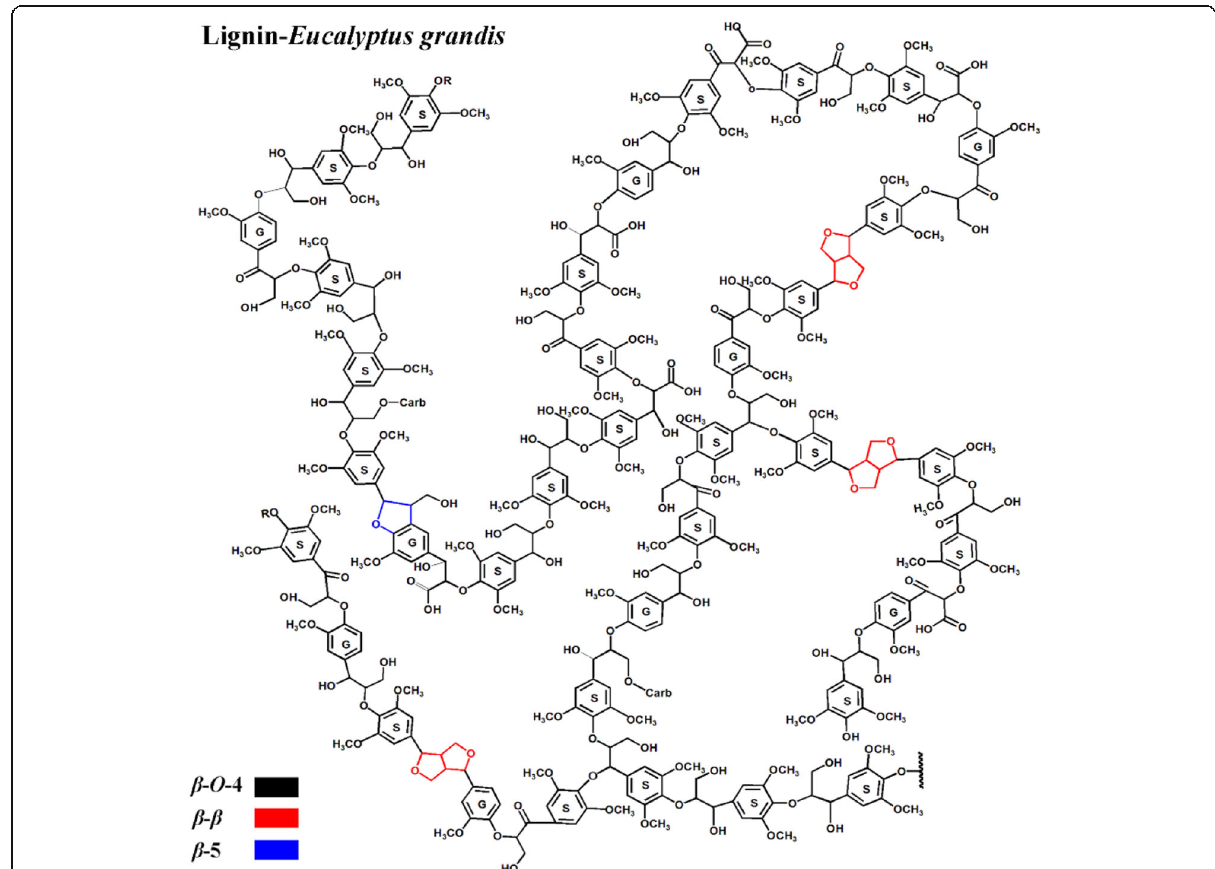
Fig. 2 Structural of Eucalyptus lignin with the main units and linkages. Reprinted with permission from ref.